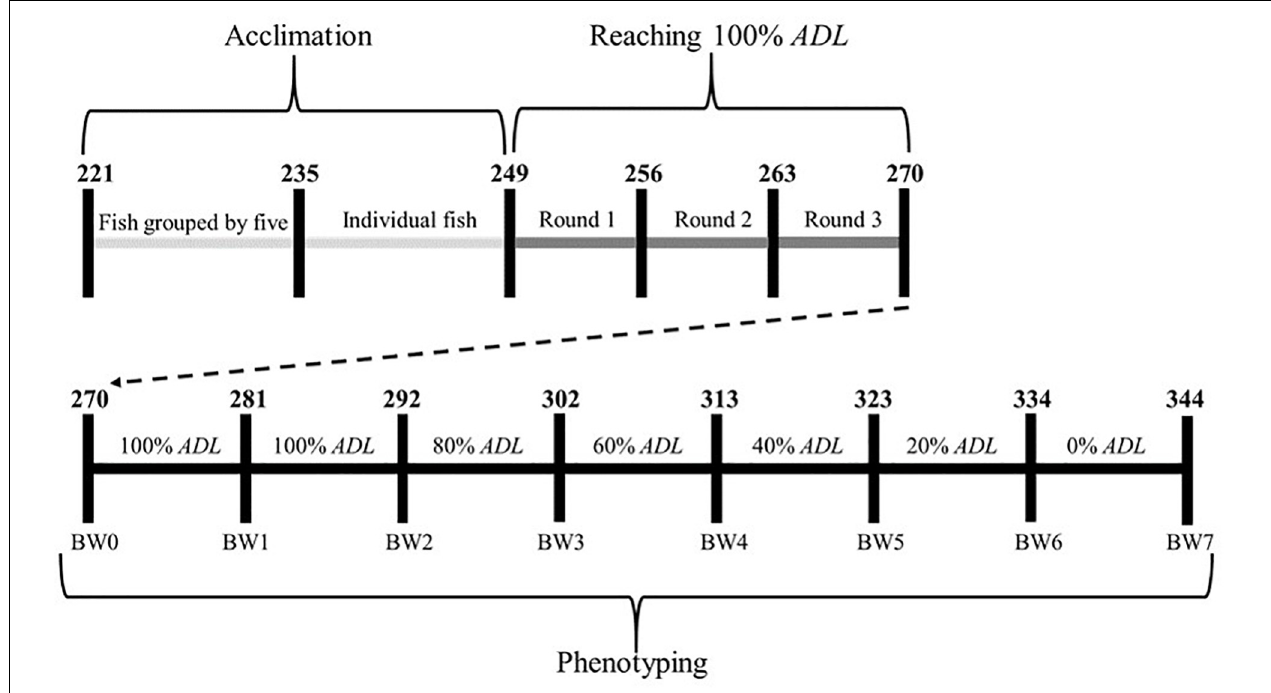
FIGURE 1 | Experimental schedule applied to each fish. Fish age (in days post hatching) at each step is indicated by the numbers. ADL , ad libitum feeding rate; BW, body weight